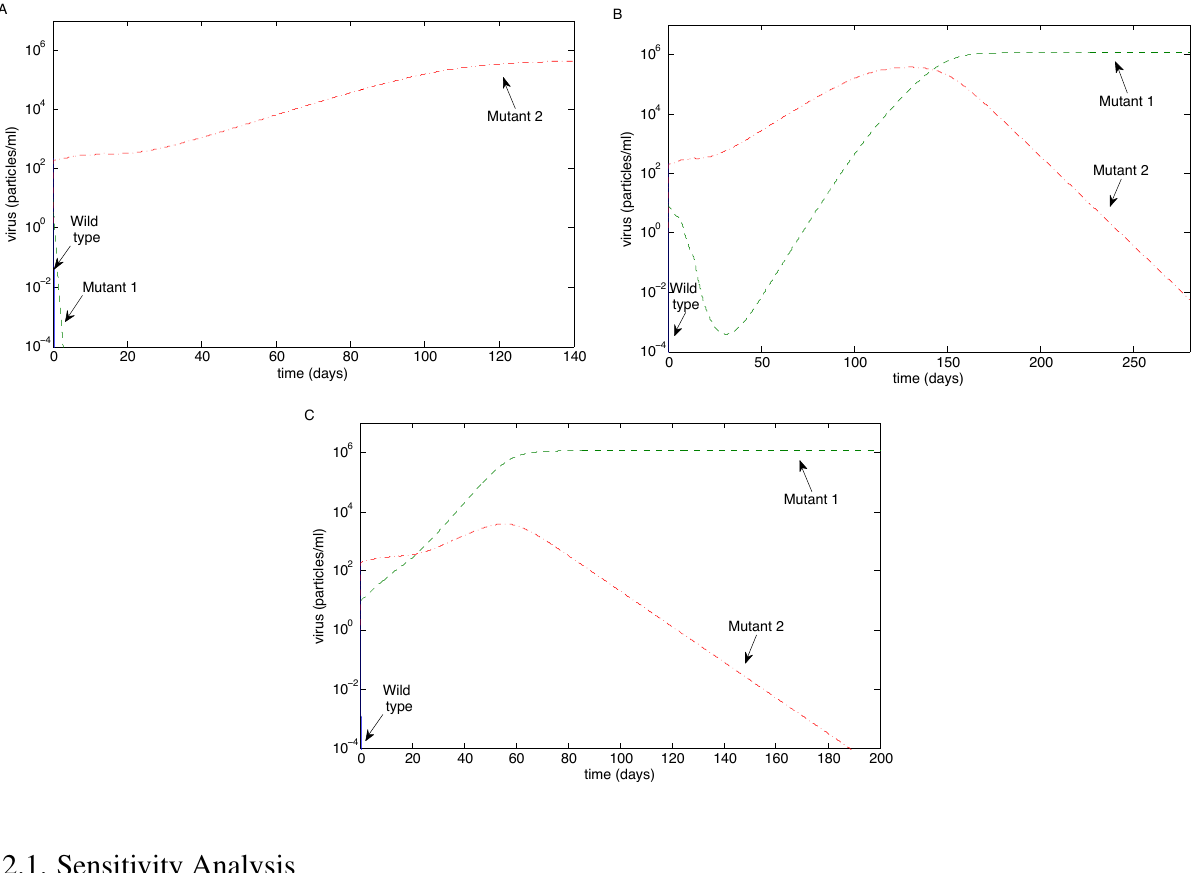
Figure 6. The case when the mutation rate of Mutant 2 is high ( (cid:15) Mutant 1 has 10 -fold resistance to the antibodies, Mutant 2 has 100 -fold resistance to the antibodies and m = 10 , recreating the conditions of Figures 3B, 4B and 5B ( i.e. , the cases of 10 -fold magnification), except for the high mutation rate of Mutant 2 . ( A ) Unlike Figure 3B, Mutant 2 escapes; ( B ) unlike Figure 4B, Mutant 1 persists; conversely, Mutant 2 is eradicated, despite its extremely high mutation rate; ( C ) the persistence of Mutant 1 , similar to Figure